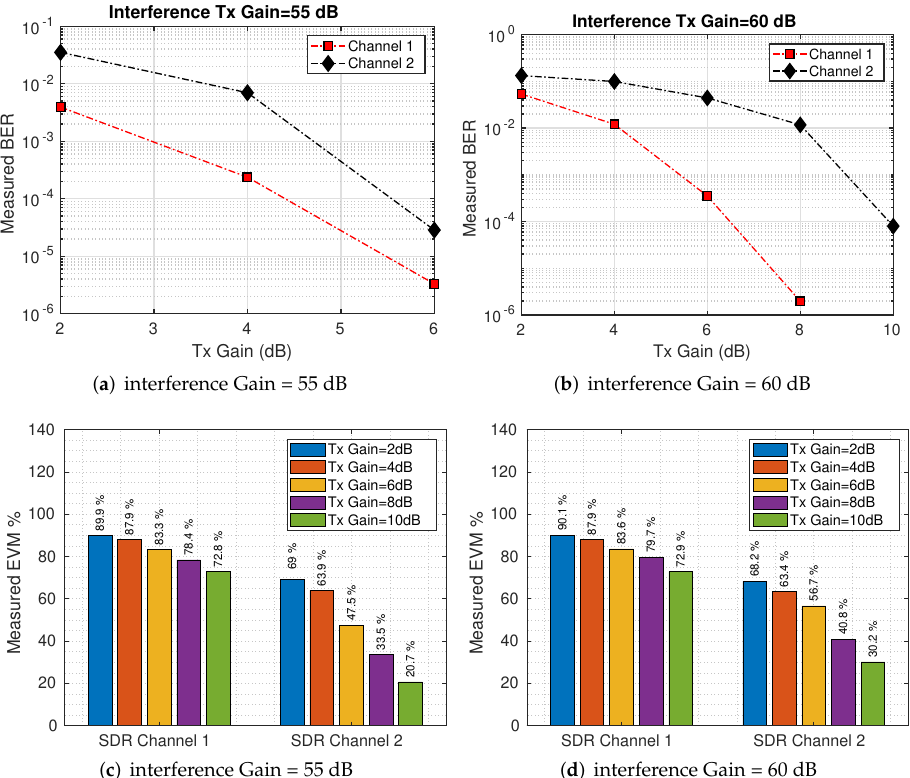
Figure 9. Measured MIMO BER of channel 1 and channel 2 in the presence of the MIMO interference when the metal enclosure was